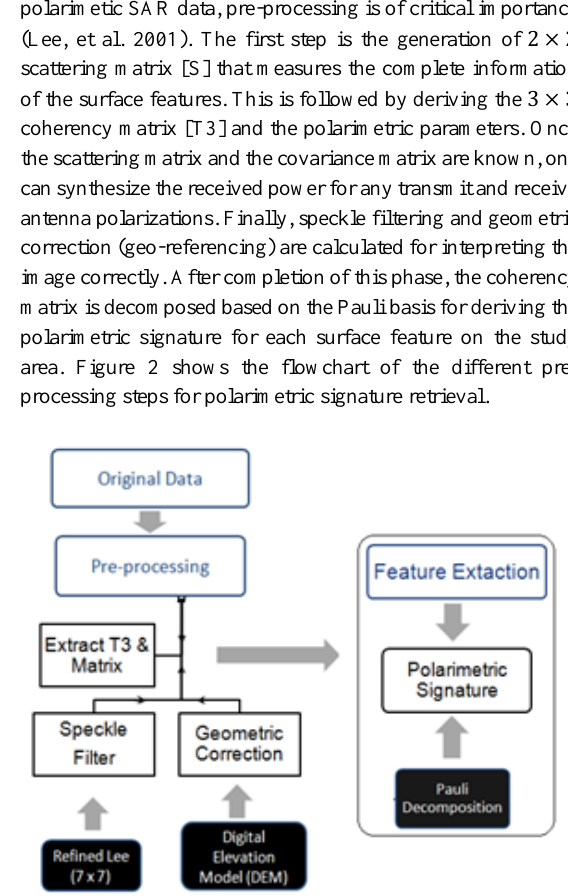
Figure 2. Flowchart of the different pre-processing steps for polarimetric signature retrieval.